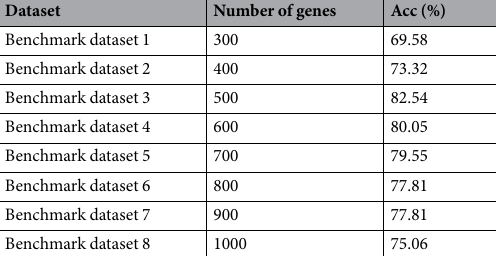
Table 4. The predictive results of eight benchmark